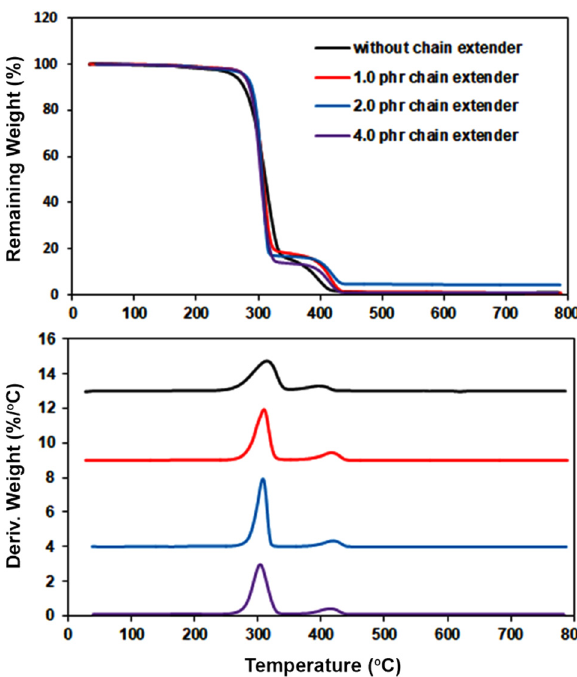
Figure 4: TG ( upper diagram ) and DTG ( lower diagram ) thermograms of PLLA - PEG - PLLA without and with chain - extension.